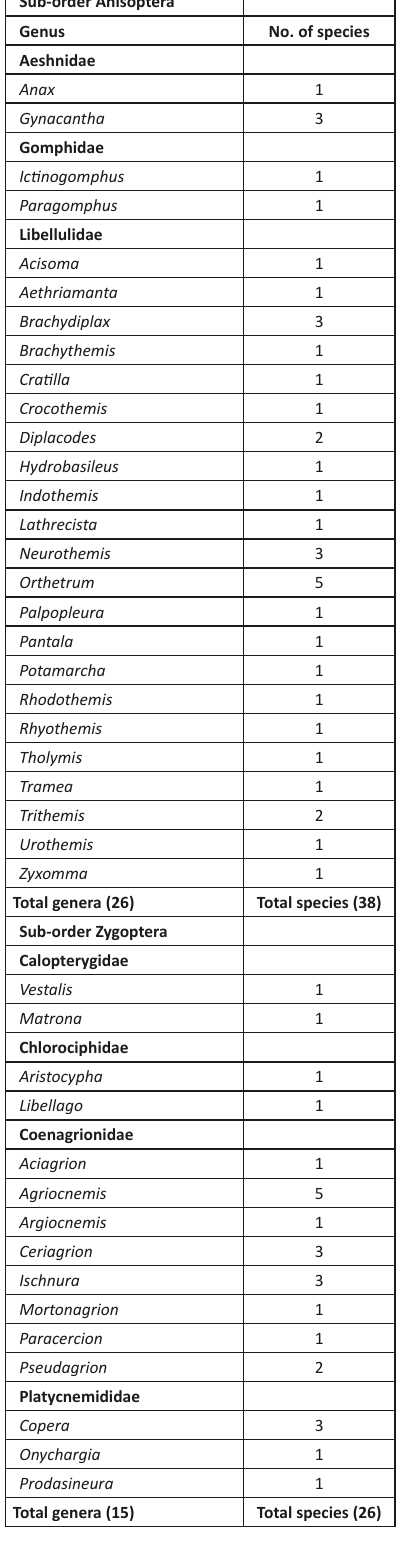
SUST campus on 28 October 2014 while Orthretrum glaucum and Tramea basilaris were observed from